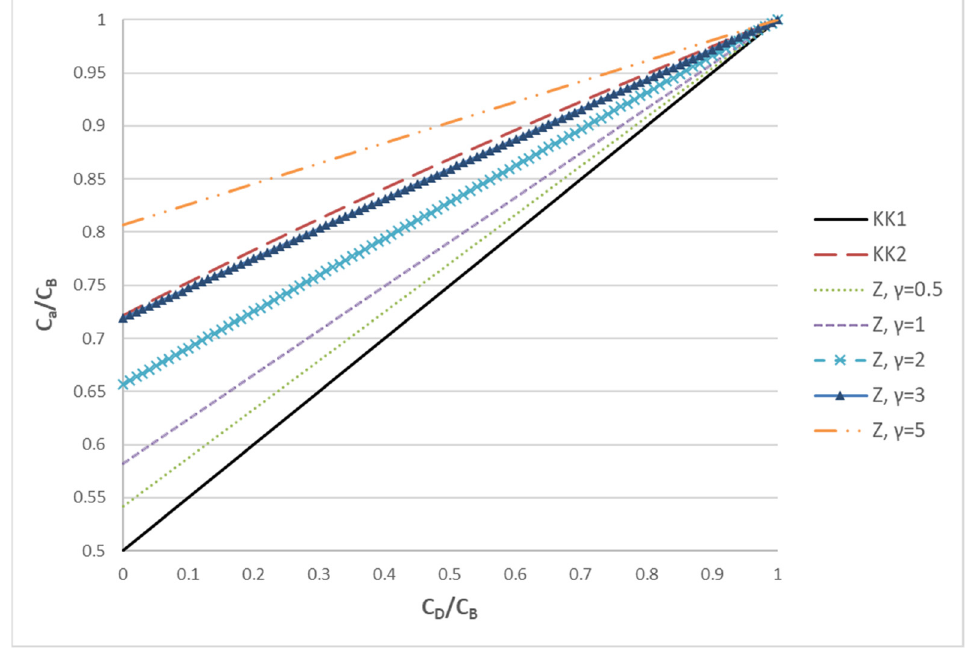
Figure 1. The ratio of C a /C B plotted versus the ratio C D /C B in order to assess the trends of three different approaches (KK1, KK2, Z) for estimating the characteristic concentration C a .